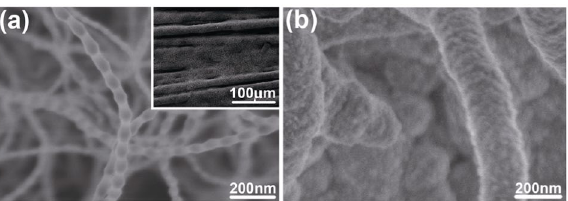
Fig. 1 Typical SEM images of as-grown and BN-coated BNNTs: (a) as-grown BNNTs and (b) BN-coated BNNTs with deposition time of 20 min.